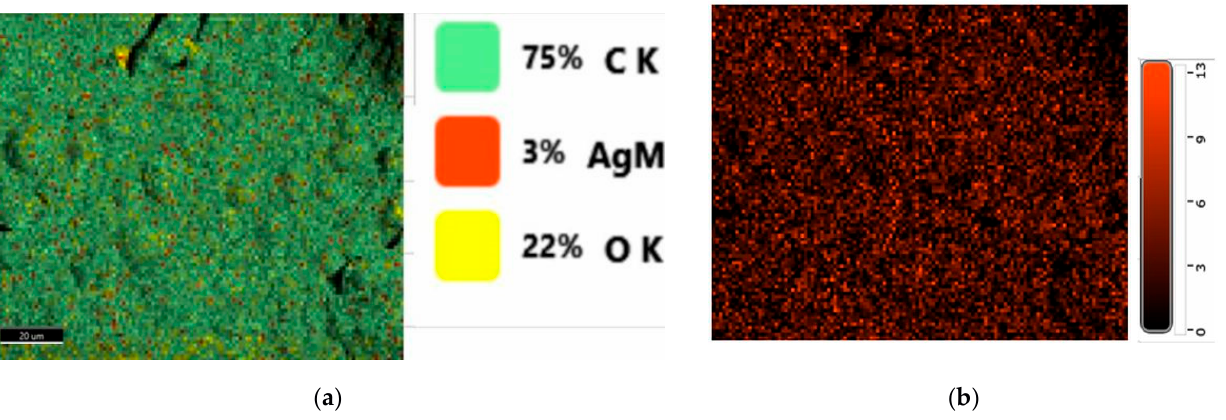
Figure 5. Element overlay ( a ) and visualization of Ag distribution ( b ) within the EDX map of the transverse fractured section of the PLA/S biocomposite. ×1000 magnification (scale bar = 20 μ m)